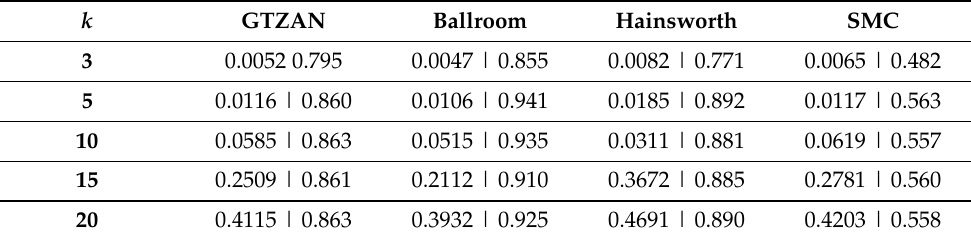
Table 3. “Average inference time | Average F-measure” on different settings of first k frequency components on evaluation datasets.